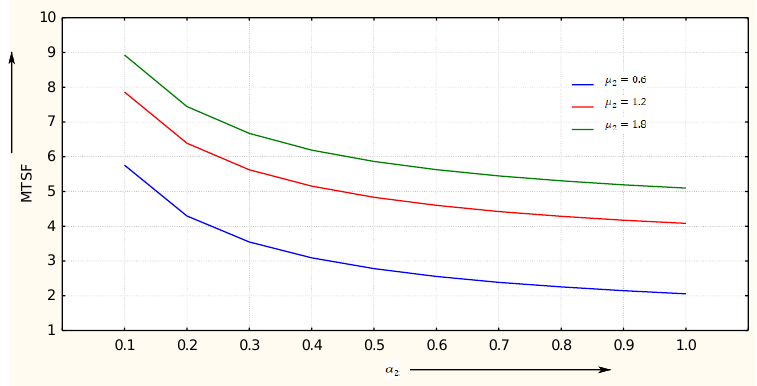
Figure 5. Behaviour of MTSF w.r.t 𝛼